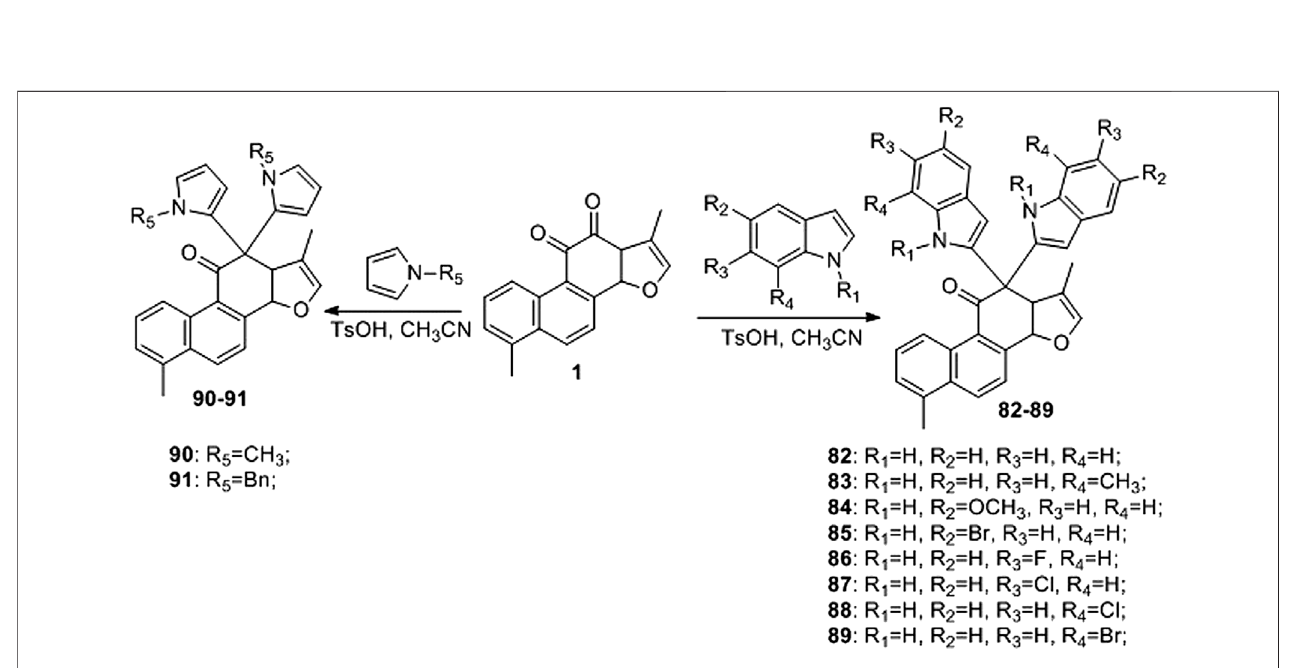
FIGURE 11 | Synthetic route of 12-position of tanshinone I ( 82 – 91